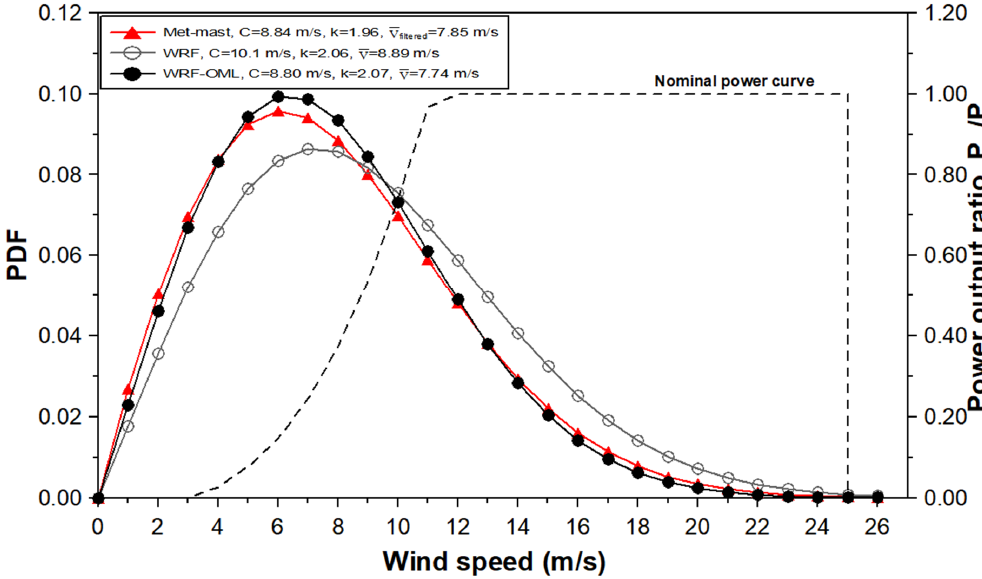
Figure 10. Weibull distribution of the met-mast, WRF, WRF-OML, and power curve of the wind turbine used in the study. V filtered is mean wind speed using the filtered measurement data, P m is measured power, and P r means rated power.